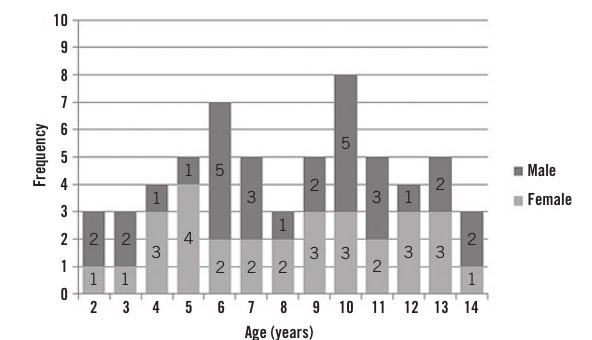
figurE 2 − Distribution of individuals according to their gender and age groups. The heights of the bars represent the frequencies of children for each gender